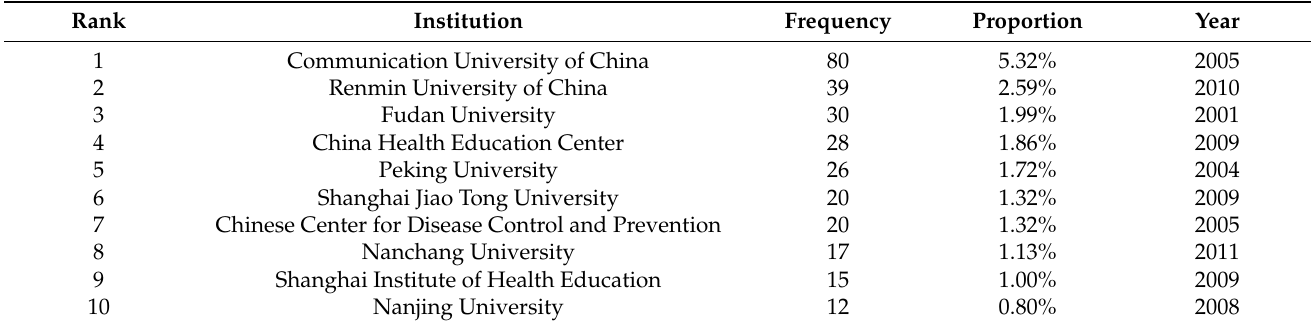
Table 3. Top 10 research institutions in the field of HC in